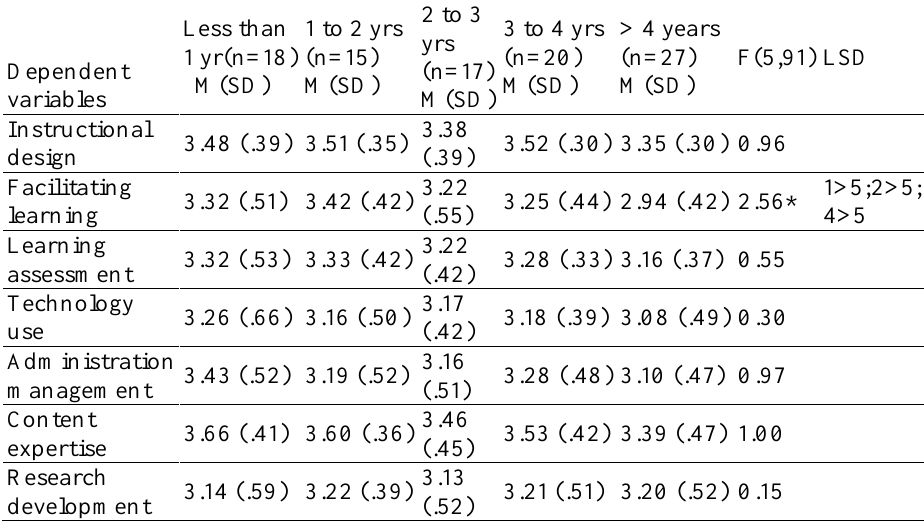
Perceptions of Different Experiences of Online